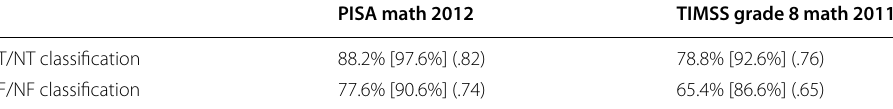
The first number is the percentage of items where all six scorers agreed on the classification. The number in the straight brackets is the percentage of items for which at least 5 scorers agreed. The number in parentheses is inter-rater reliability as measured by Fleiss’ kappa